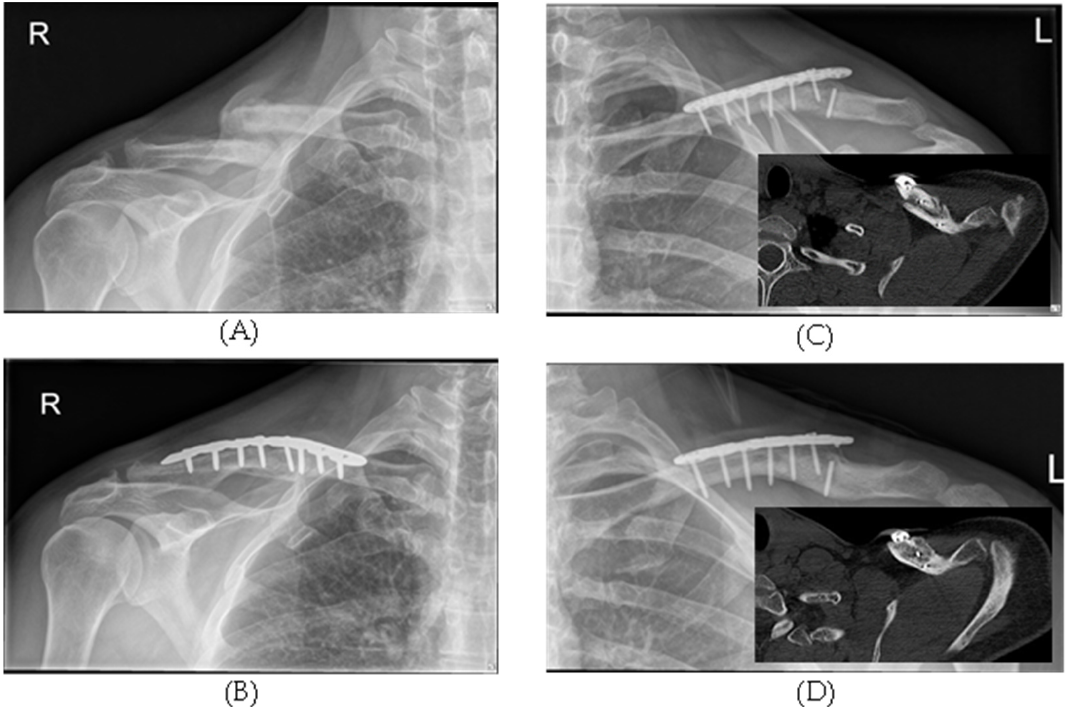
Figure 2. ( A ) Non-union of the right clavicle in a 51-year-old male. ( B ) Six months post-surgery, bony healing was achieved using standard-of-care treatment with non-union interfragmentary scar resection, autologous bone graft, and plating; ( C ) a 26-year-old male patient who received plating of a mid-third clavicle acute fracture showed a non-union associated with a hardware failure. The CT scan (insert) confirms the indirect signs of non-union (i.e., screw failure, implant loosening). The patient refused revision surgery and focused high-energy shockwaves were applied. Six months after treatment, bridging occurred ( D ), confirmed by another CT scan (insert).